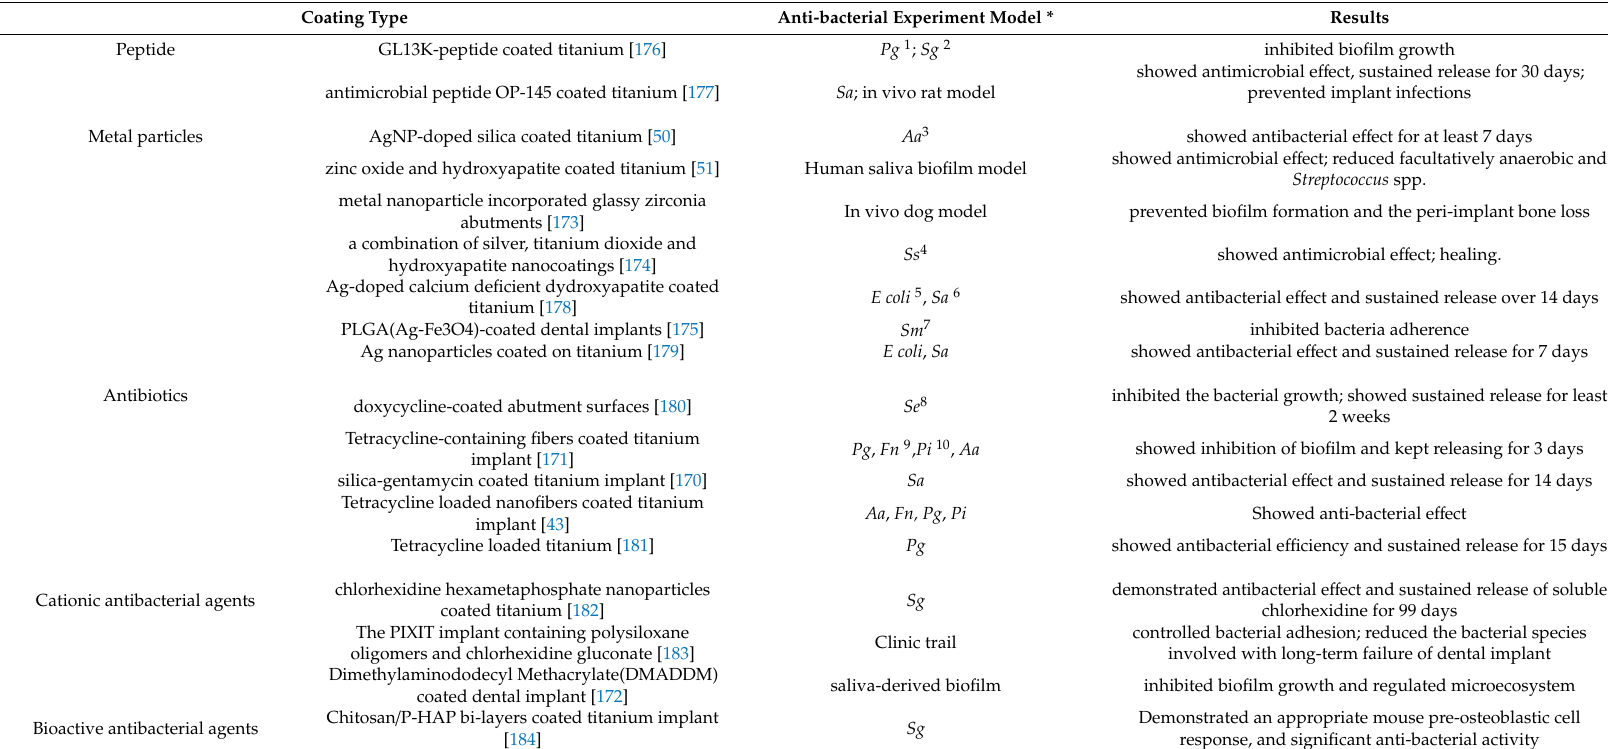
Table 3. Anti-bacterial DDS coating for the prevention of dental